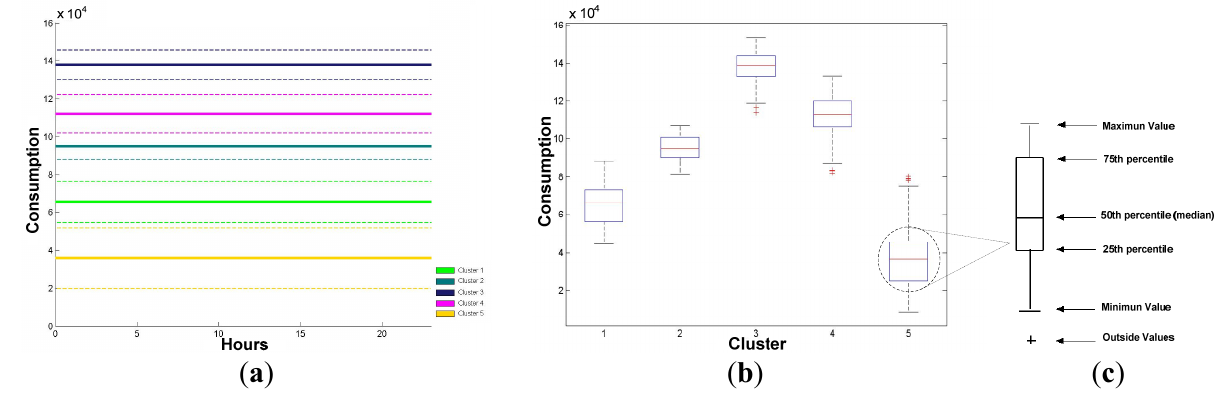
Figure 9. ( a ) Average aggregate load ± standard deviation (the y-axis shows values of power consumption in W and the x-axis 24 hours per day); ( b ) box plot (the y-axis presents values of power consumption in W across the five clusters in the x-axis); ( c ) box plot